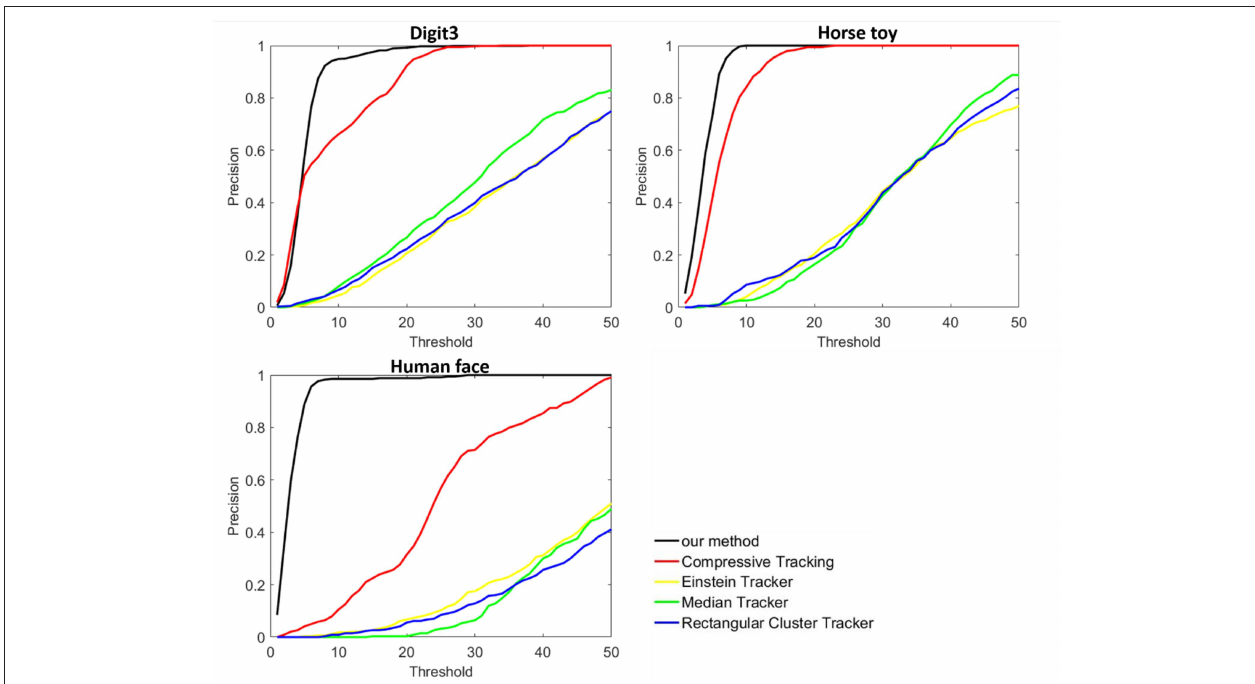
FIGURE 5 | Tracking results on three event-stream recordings captured by DVA128 sensor (from left to right are Digit3, Horse toy, and Human face, respectively). Comparison were done with four other tracking methods.